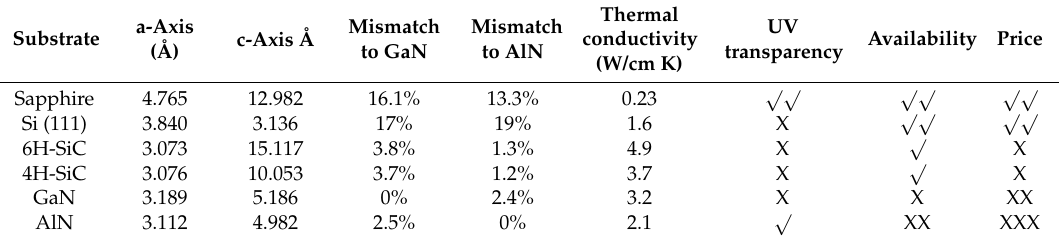
Table 1. Lattice parameters and properties of substrate materials for growth of deep ultraviolet light-emitting diodes (DUV LEDs) [33,34]. Mismatch calculations for sapphire take into account the 30 degree in-plane